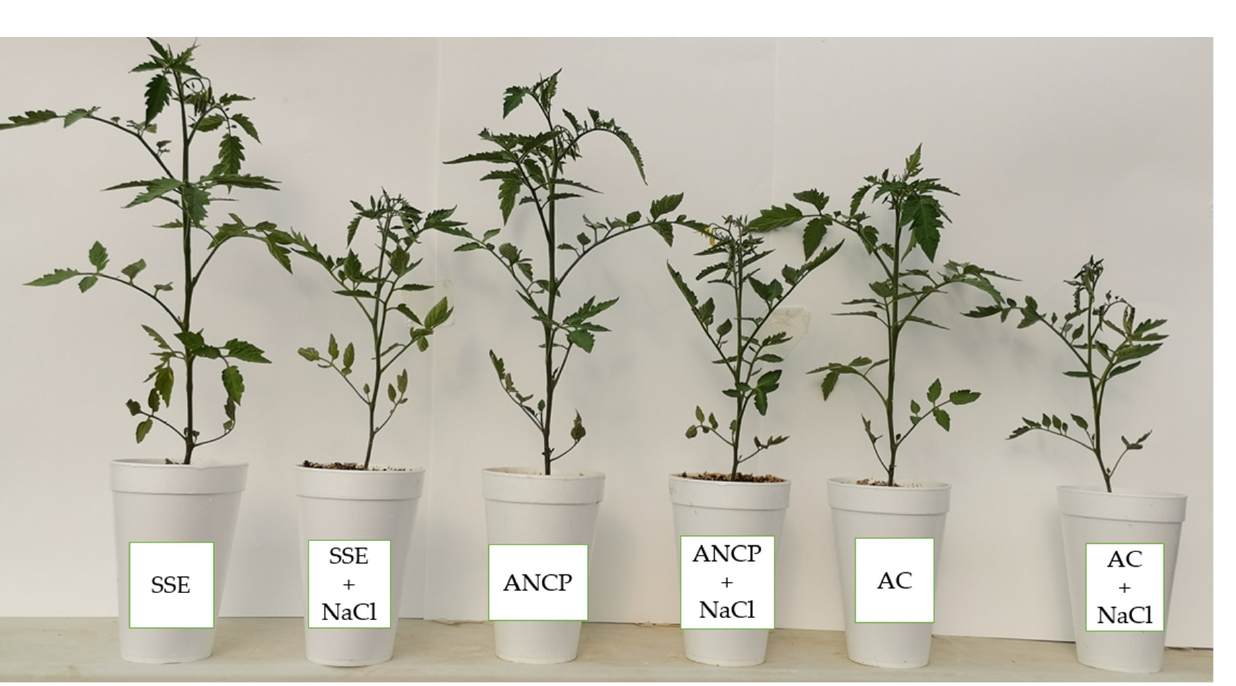
Table 2. Fresh and dry biomasses of tomato seedlings at the end of the experiment.